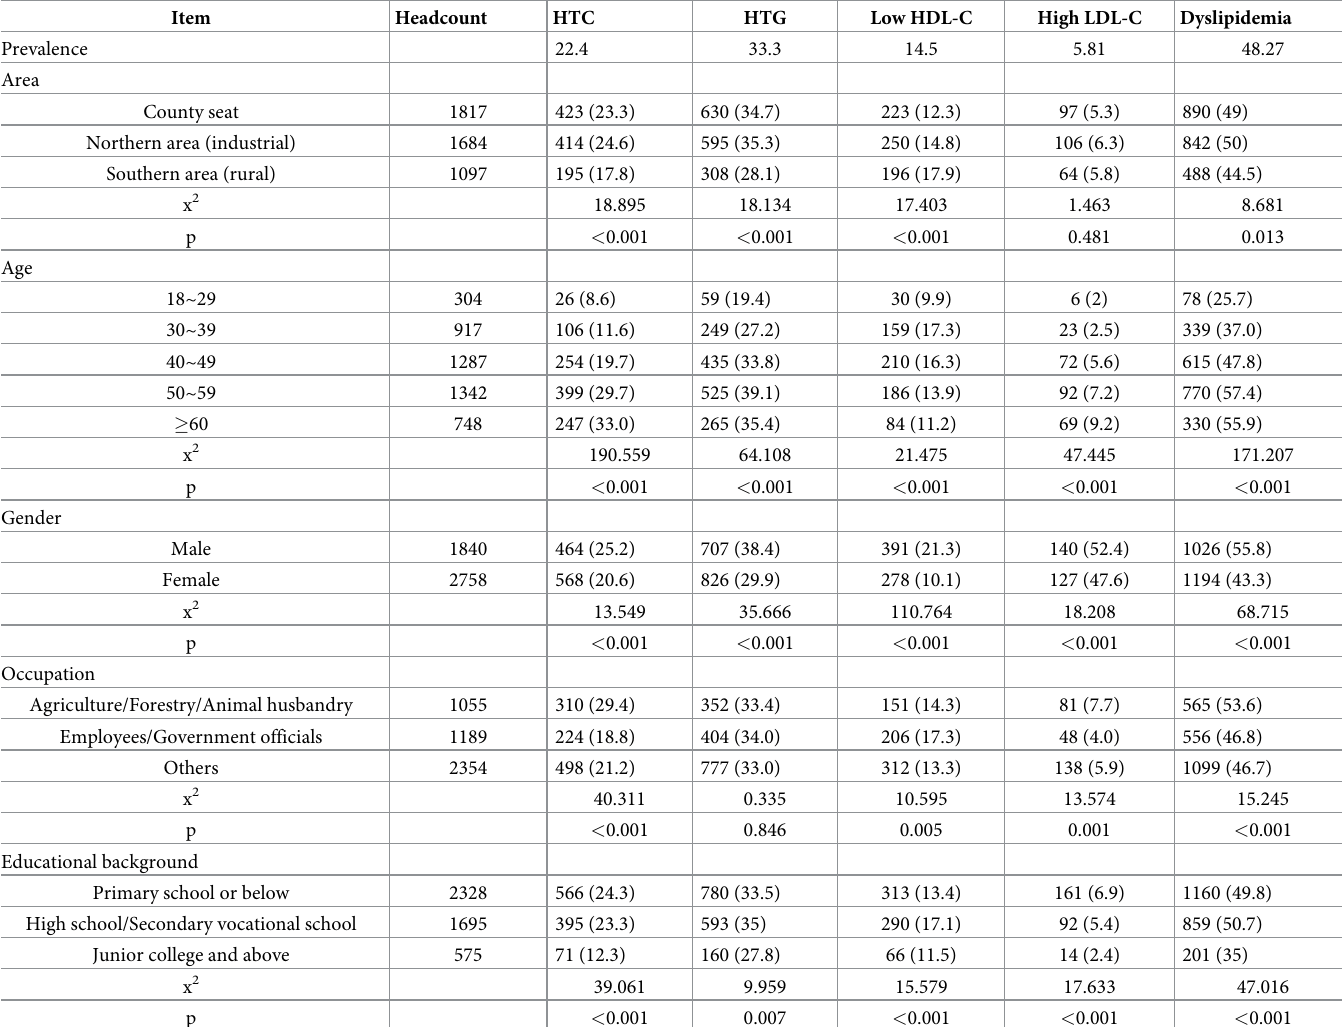
Table 2. Prevalence of various types of dyslipidemia [Headcount